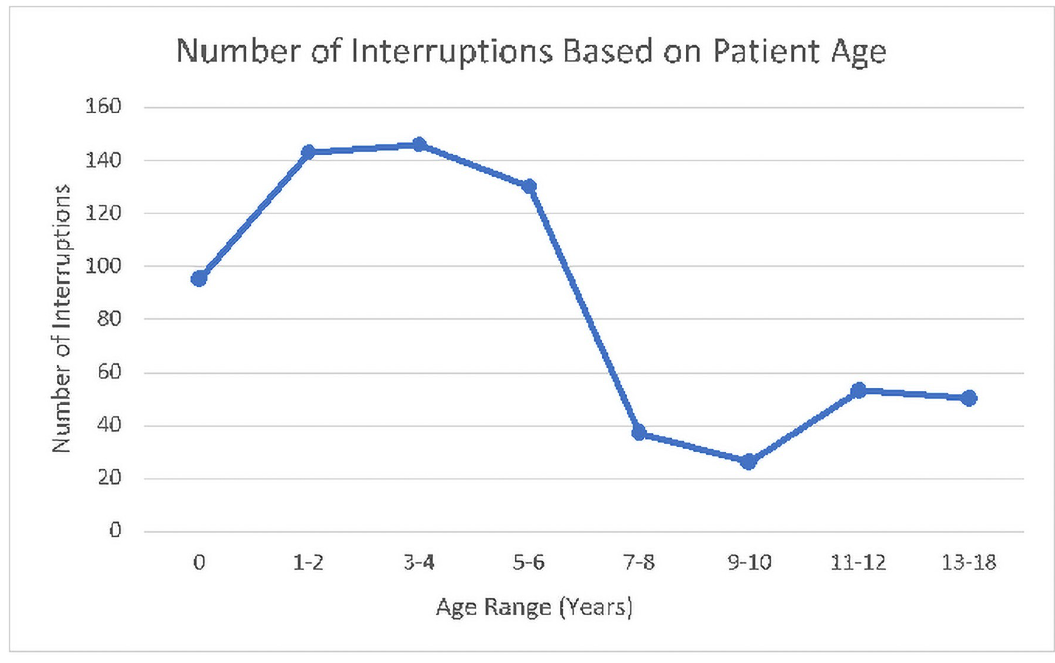
Fig 1. Number of interruptions based on patient